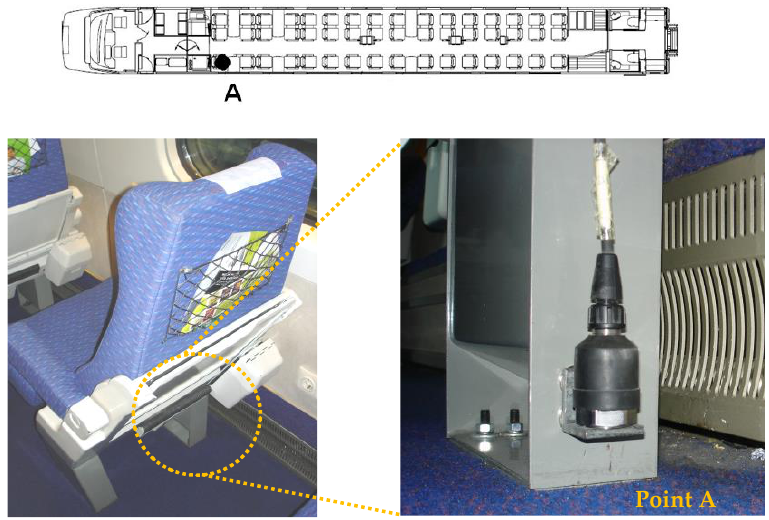
Figure 15. Measurement of acceleration inside the BAS vehicle of Alfa Pendular train.